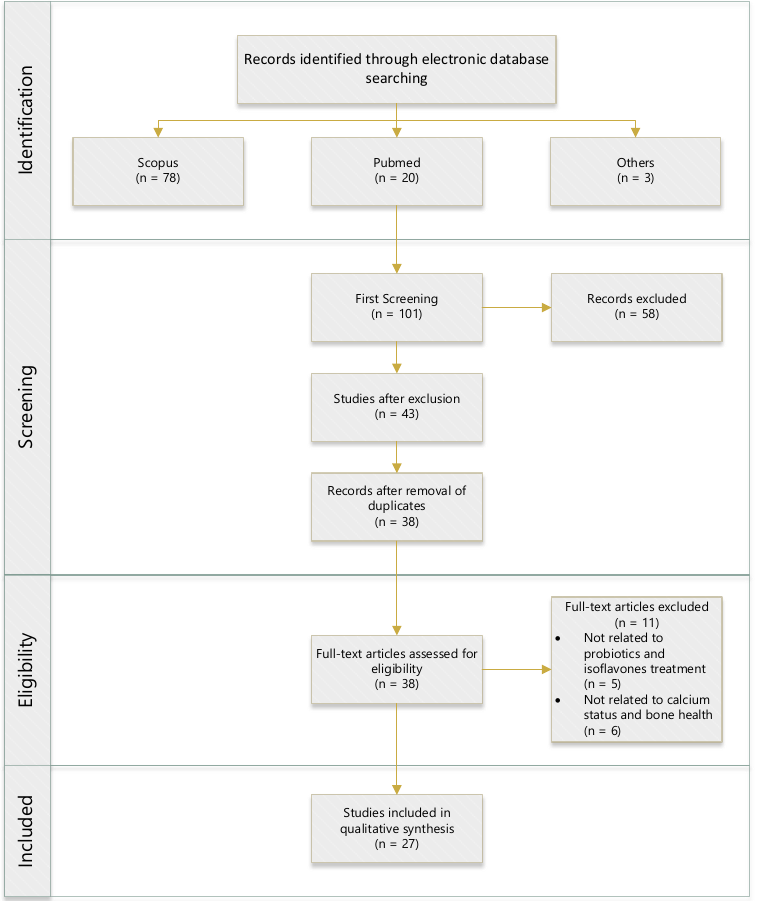
Figure 1. Flow diagram of the literature search and process of selection. (n = numbers).